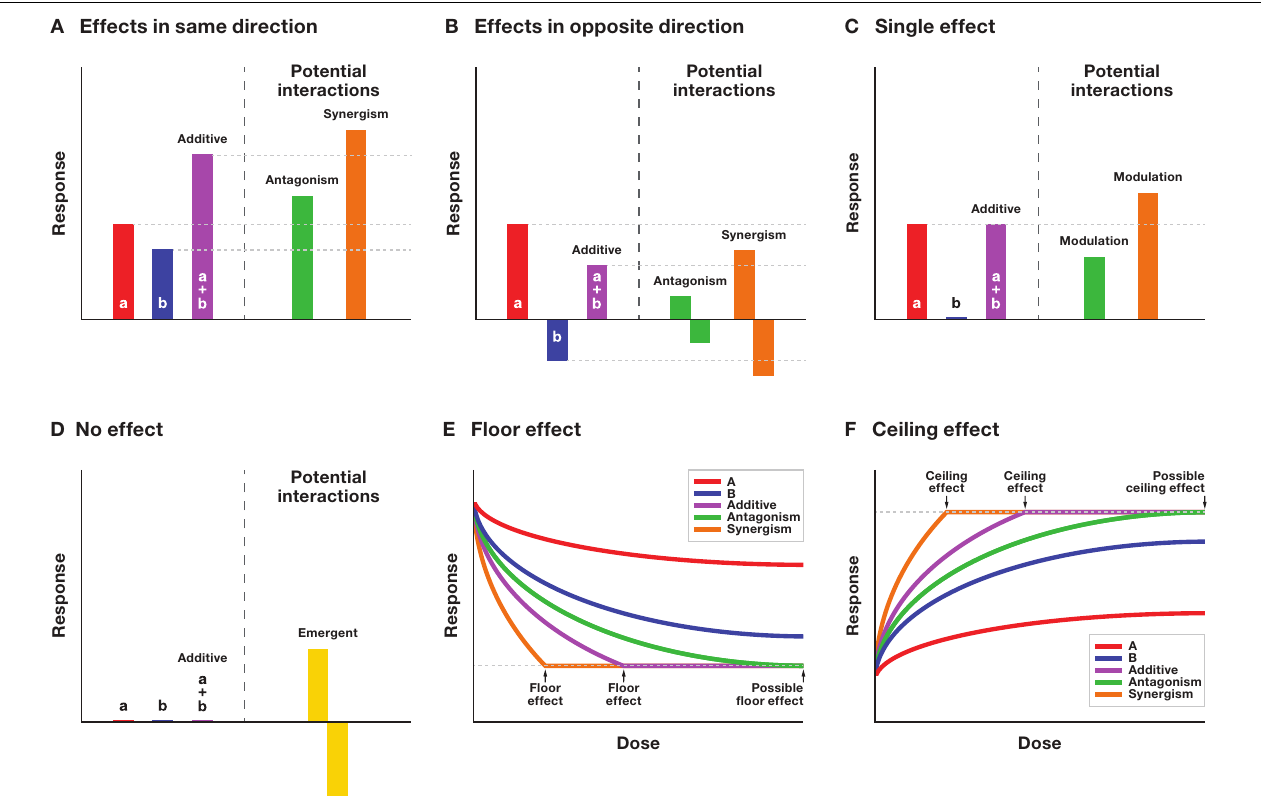
FIGURE 1 | Classification of different types of interactive effects of noise and light pollution. Various scenarios where noise and light pollution have either the same (A) , opposite (B) , no effect (C,D) or a dose-dependent effect (E,F) when exposed in isolation. The effect of noise and light can either add up (a + b) or interact and lead to a lower (antagonistic) or higher (synergistic) than expected effect when compared to the additive effect. (A) Scenario when the effect of noise and light pollution is in the same direction. (B) Scenario when noise and light have opposite effects. Antagonistic effects can be in either direction, as long as they are closer to zero compared to either one of the single effects or the additive effect. Synergistic effects should be either further away from zero compared to additive effects, or single effects, but not necessarily both. (C) Modulation scenario where one sensory pollutant has no effect on its own. Interactive effects are considered to be a modulation of the dominant pollutant by the other pollutant. The modulatory effect can either be lower (antagonistic) or higher (synergistic) than the additive effect, which is the same as the effect of the dominant pollutant. (D) Emergent scenario where both sensory pollutants have no effect on their own, whereas their combined exposure either has a positive or negative effect. (E) Illustration of the floor effect. Depending on the dose of pollutant (A,B) , their additive effect may reach a physical or energetic limit. Synergistic effects can only be assessed at low dosage levels, whereas at high dosages, antagonistic and additive effects may not be discernable. (F) Illustration of the ceiling